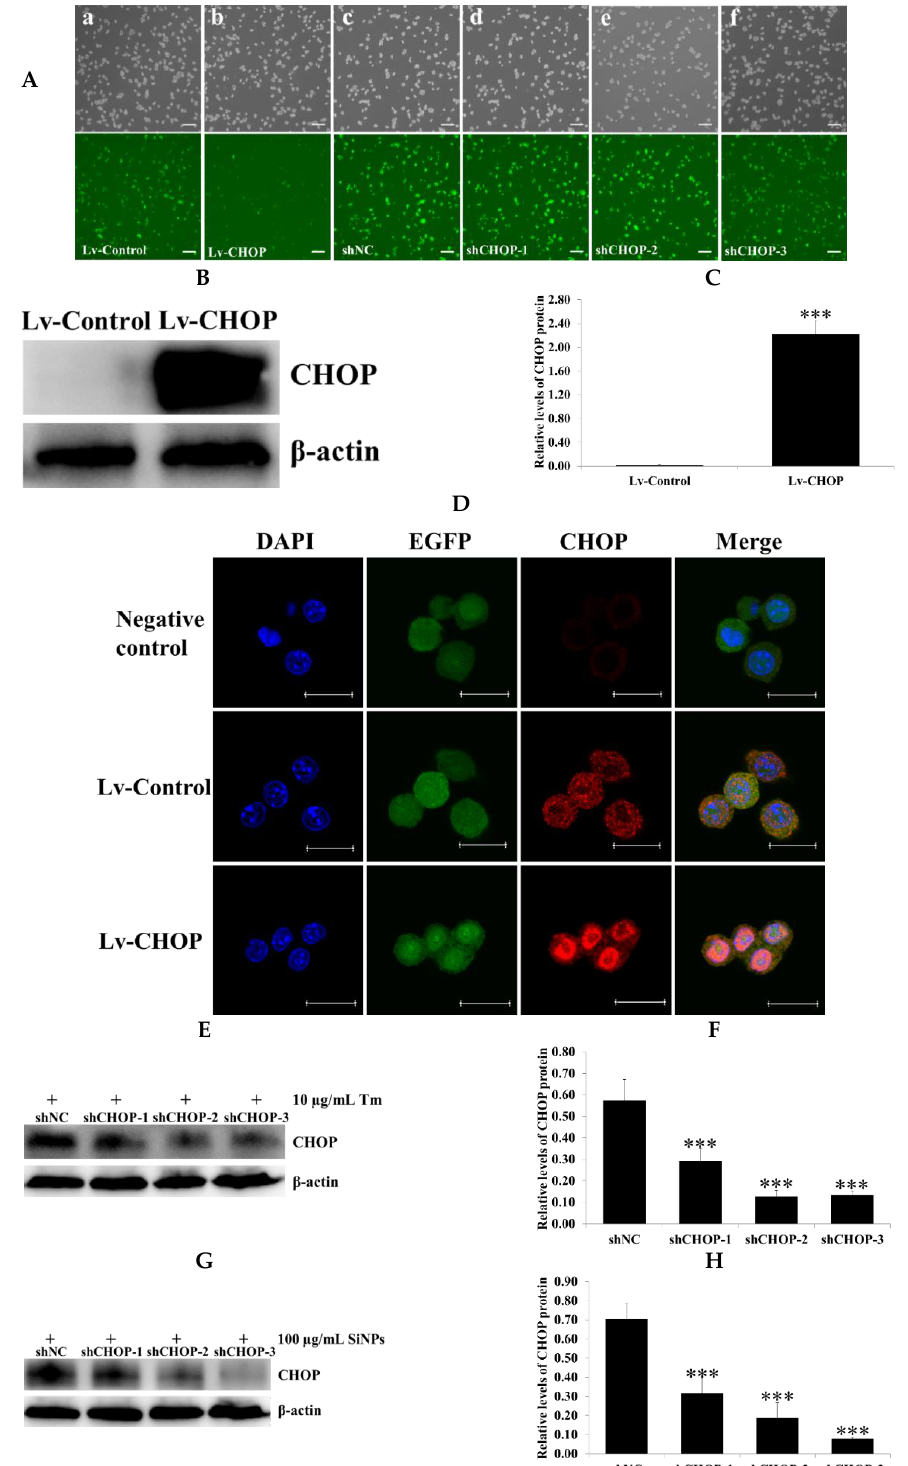
Figure 6. Overexpression and knockdown efficiency of CHOP lentivirus after transduction into RAW 264.7 macrophage cells. RAW 264.7 macrophage cells were transduced with lentivirus vectors (Lv)-CHOP, Lv-Control, three shCHOPs, and shNC lentiviruses, and the stably expressed cells were selected. ( A ) The plasmids themselves could express enhanced green fluorescent protein (EGFP, green fluorescence), and the proportion of the stably expressed cells expressing EGFP was above 95% by